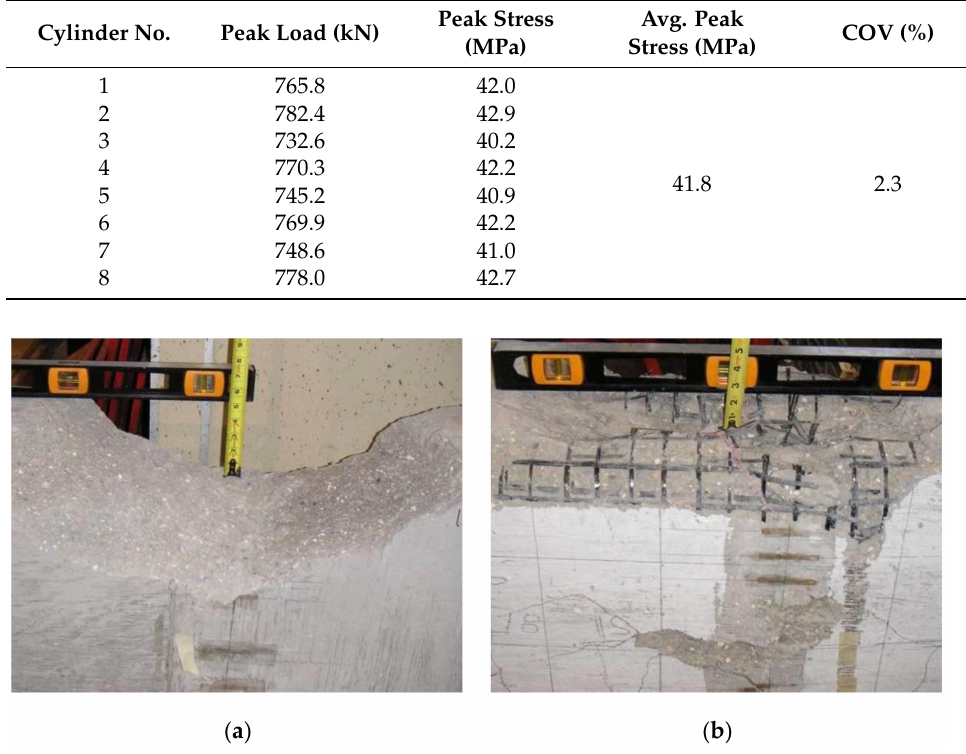
Table 3. Experimental results for unconfined concrete cylinder specimens used to evaluate the concrete strength of beams.